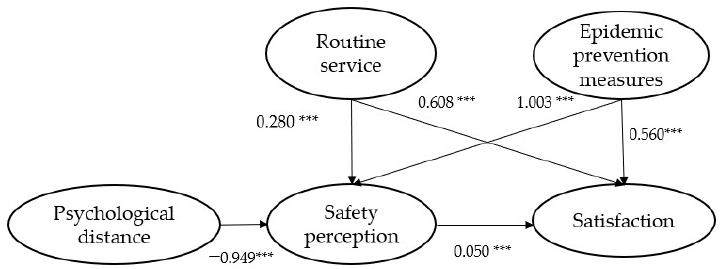
Figure 3. Structural equation model. Note: *** is significant at p < 0.001 level.